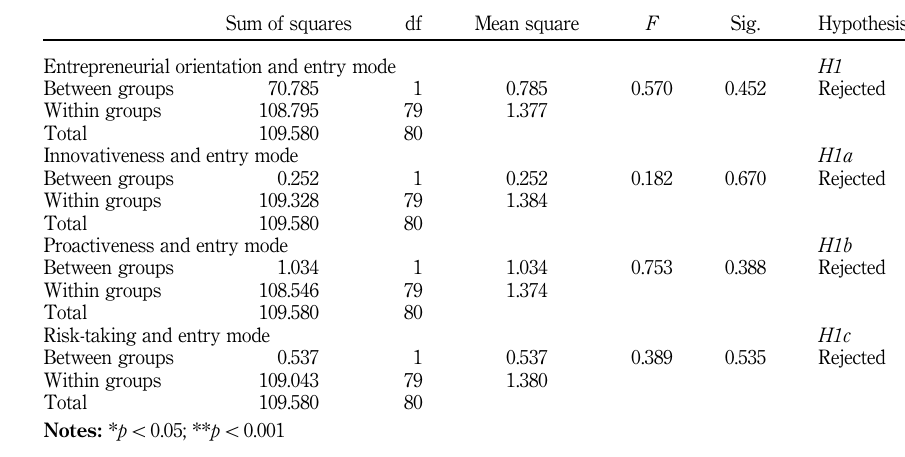
Table IV. Entrepreneurial orientation and entry